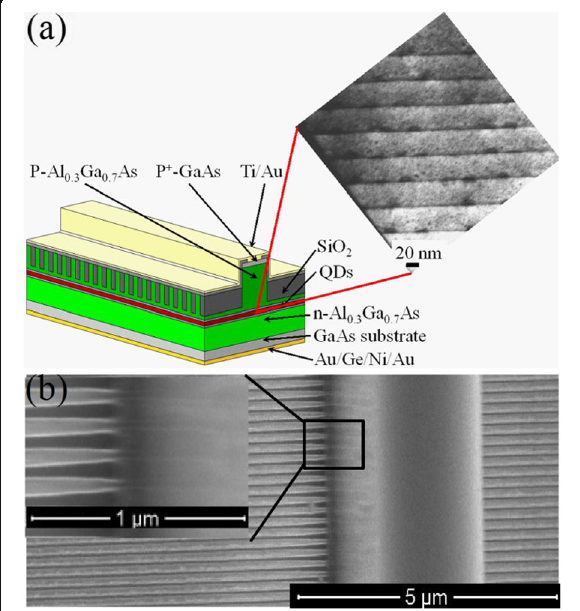
Fig. 1 Schematic diagram and morphology of InAs/GaAs QDs LC- DFB laser structure. a Schematic diagram of InAs/GaAs QD LC-DFB laser structure. Inset: cross-sectional TEM image of the QD active layer structure. b The top view of the SEM image of LC-DFB laser structure with first-order grating. Inset: enlarged SEM image focus on the joint between the grating and ridge